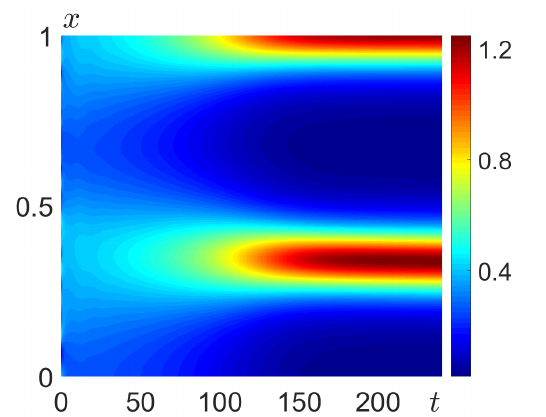
Figure 3. Heat map visualization of the pattern formation in Systems (1), (2) from the random initial state. Here, a = d = e = 0.5, b = c = 1, D u = 5 × 10 − 4 , D v = 0.02, and ε = 0.